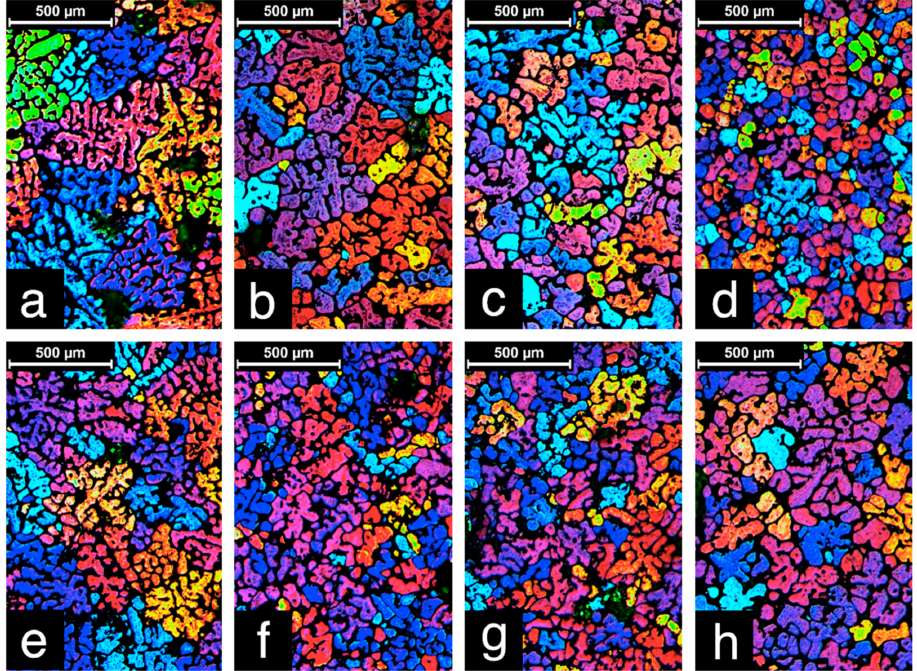
Figure 10. Colored micrographs showing grains in semisolid B319+Fe alloy after isothermal heat treatment at 591 ◦ C ( a – d ) and 595 ◦ C ( e – h ) for 0 ( a , e ), 30 ( b , f ), 60 ( c , g ), and 90 s ( d , h